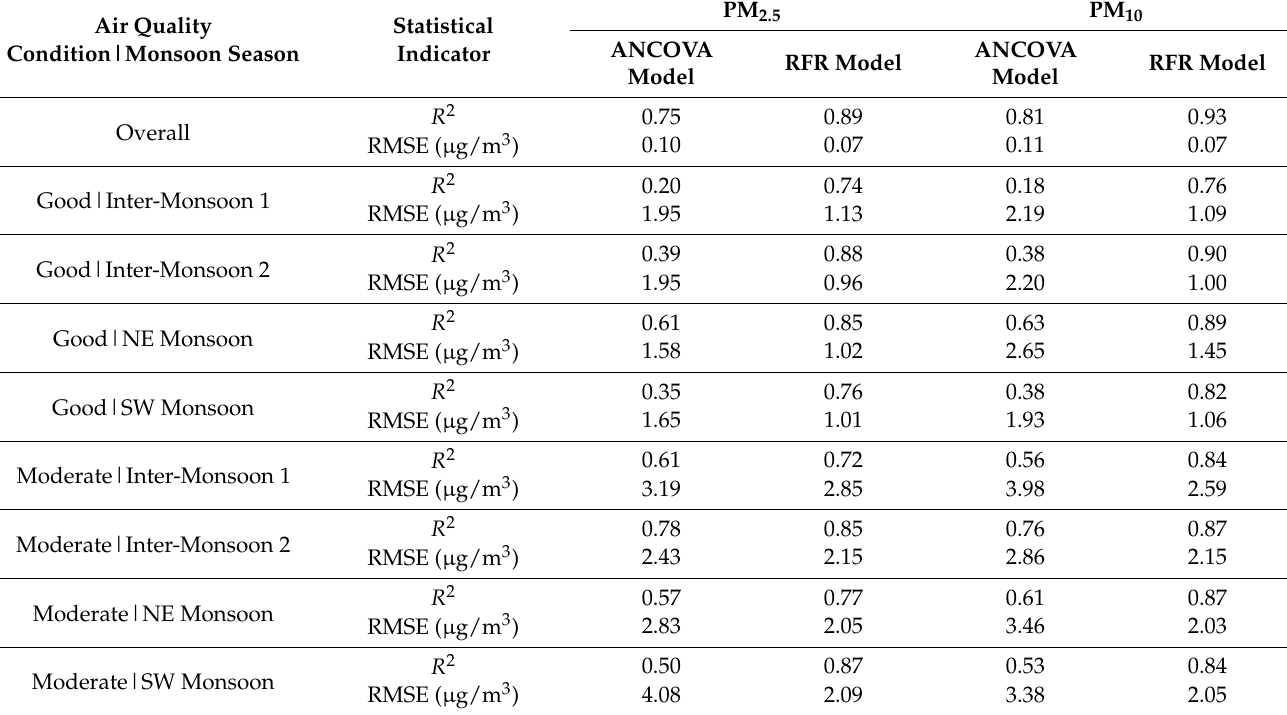
Table 3. Comparison of determination coefficient ( R 2 ) and root mean square of the errors (RMSE) of the ANCOVA and RFR models for estimating daily PM 2.5 and PM 10 concentrations during good and moderate air quality conditions in different monsoon seasons in Singapore from March 2016 to February